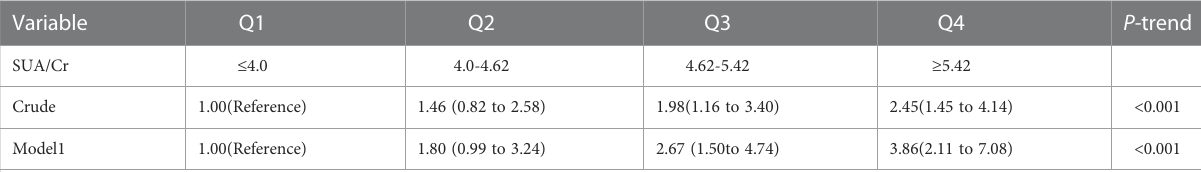
TABLE 3 Odds ratios (95% con fi dence intervals) for the MetS associated with quartiles of SUACr. Variable